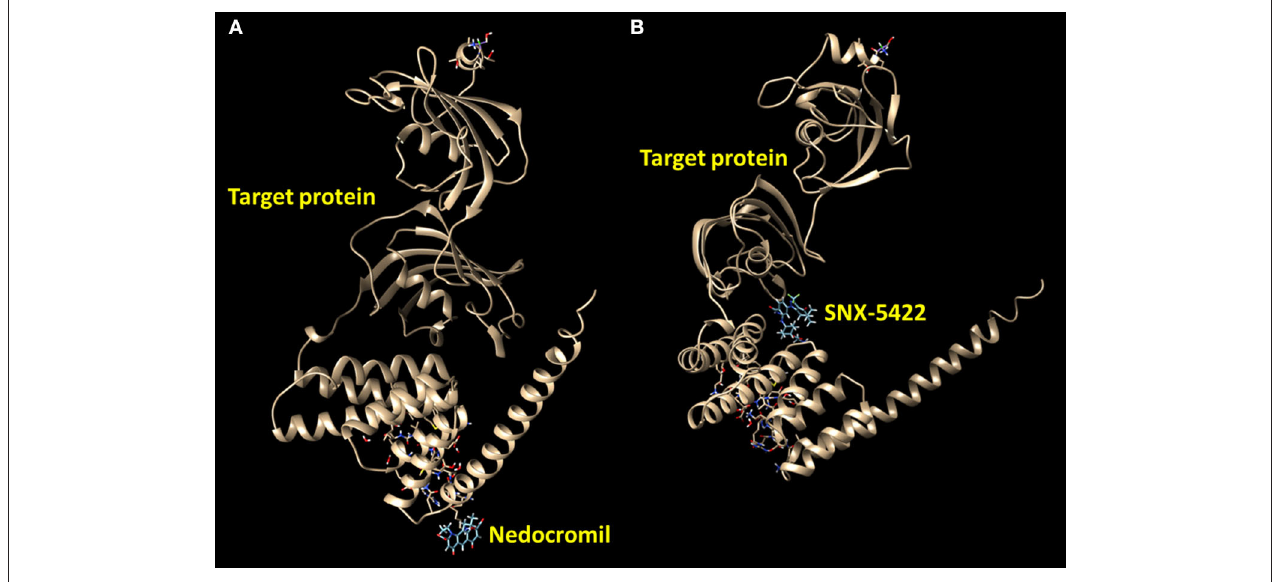
FIGURE 5 | Predict binding modes of protein–drug interactions. Molecular graphics images were produced by the UCSF Chimera package. Binding modes were scored using their FullFitness and clustered. Clusters were then ranked based on the average FullFitness of their elements. (A) Nedocromil–protein; (B) SNX-5422–protein.